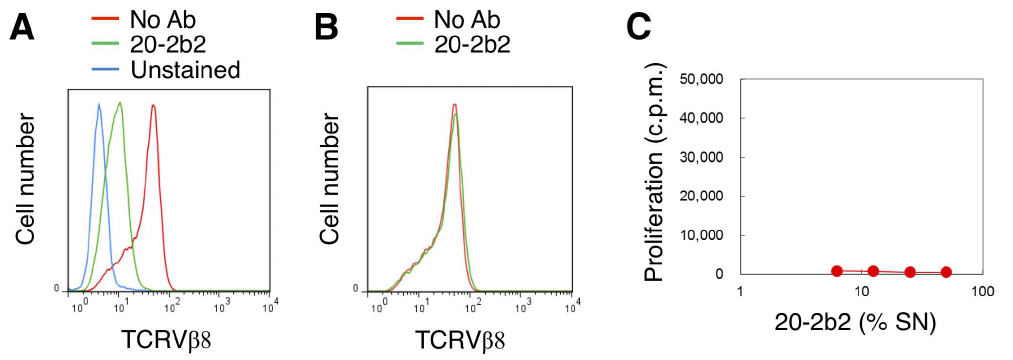
Figure 1. Non-stimulatory 20-2b2 induced the down-modulation of TCR expression. (A) Jurkat cells were cultured in the presence (green) or absence (red) of 20-2b2 (50% SN) at 37 u C. Cells were washed and stained with the anti-TCRV b 8 Ab two hours later. Unstained Jurkat cells are shown as a blue line. (B) Jurkat cells were cultured in the presence (green) or absence (red) of 20-2b2 (50% SN) at 4 u C for 20 min, and then stained with anti-TCRV b 8 Ab conjugated with FITC. (C) The PBMCs of healthy donors were cultured with the titrated amount of 20-2b2. Cell proliferation was measured two days later. Data are expressed as the mean 6 SD of triplicate cultures. The proliferation of PBMCs without a stimulus was measured as 718 6 346 cpm. Results are representative of three independent experiments (A–C).